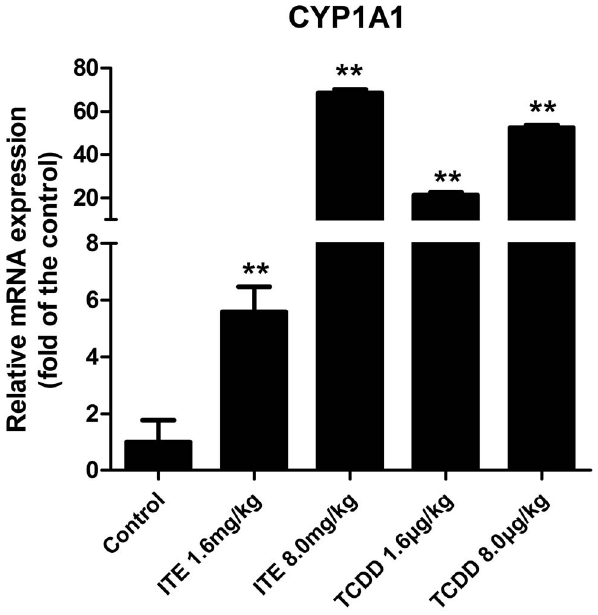
Figure 2. The activation of AhR/CYP1A1 signaling by ITE or TCDD in placental tissues. Activation of the AhR/CYP1A1 signaling was indicated by increases in CYP1A1 mRNA levels. Data are expressed as means 6 S.E.M fold of the control. **Differ from the control ( p , 0.001; n=4/group).